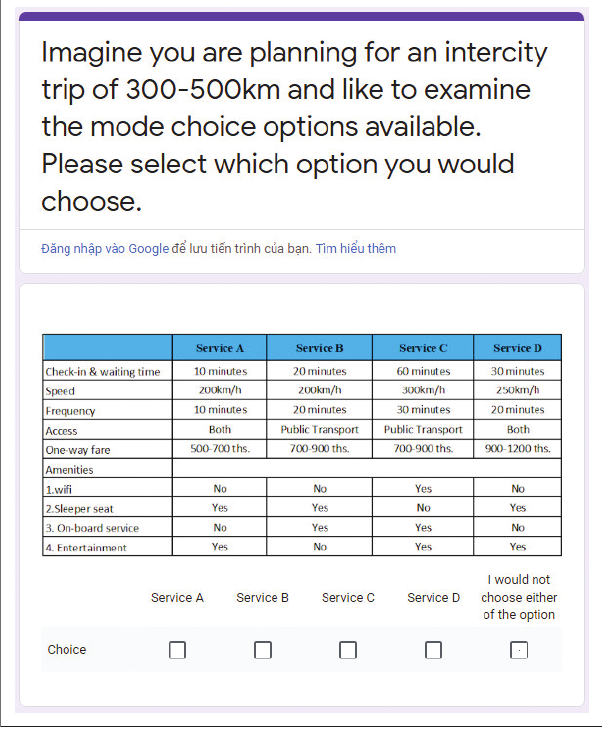
FIGURE 1: An example of questionnaire (translated from a Vietnamese version).